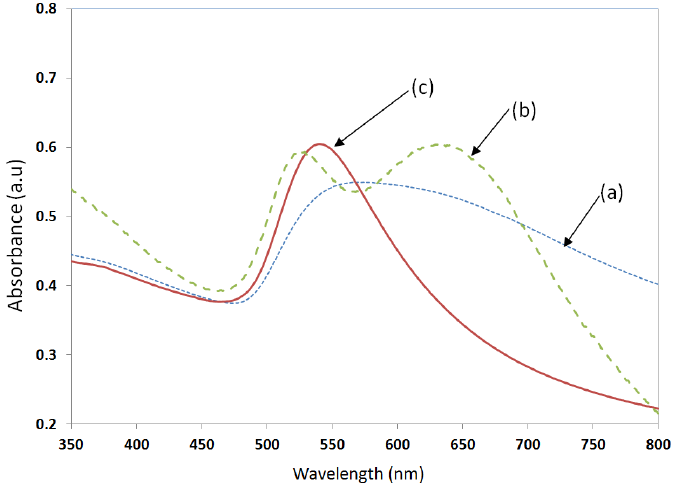
Figure 11. UV-Visible absorbance spectrum of ( a ) non-annealed sample ( b ) samples annealed at 400–450 °C, and ( c ) samples annealed at 550–600